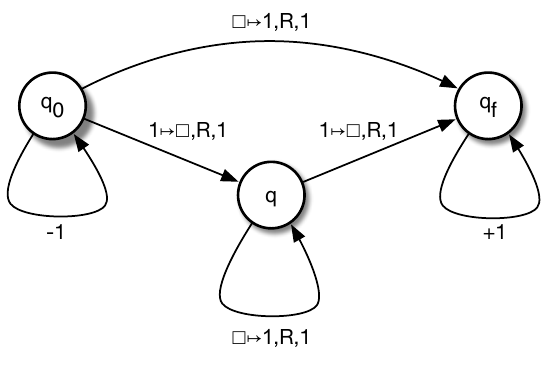
Figure 3. A reversible TM as a